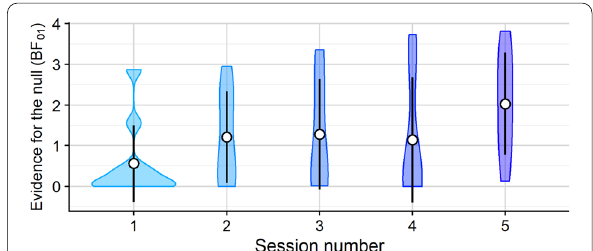
Fig. 14 Violin plots showing Bayes factors for Bayesian t -tests comparing points earned by subjects in the incongruent search conditions over experimental sessions ( y -axis) to points earned by ideal observers that used recent experience to search in the incongruent condition ( s = 1). White circles indicate the mean.